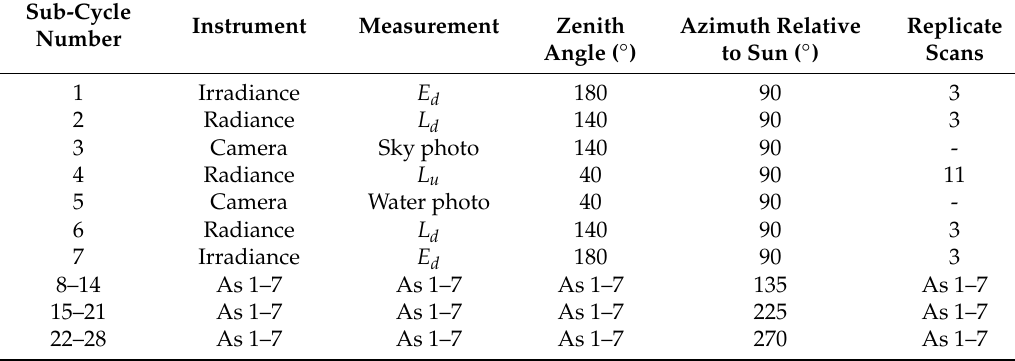
Table 1. Pan-and-tilt hyperspectral radiometer system (PANTHYR) basic data acquisition cycle. Azimuth is measured clockwise with respect to sun with a relative azimuth of 0 ◦ , meaning that the radiance sensor is pointing toward the sun, and a relative azimuth of 90 ◦ , meaning that the radiance sensor is pointing to the right of sun. A zenith angle of 180 ◦ means that the instrument is pointing vertically upward and, hence, measuring downwelling (ir)radiance. Measurements within a predefined azimuth no-go zone will be